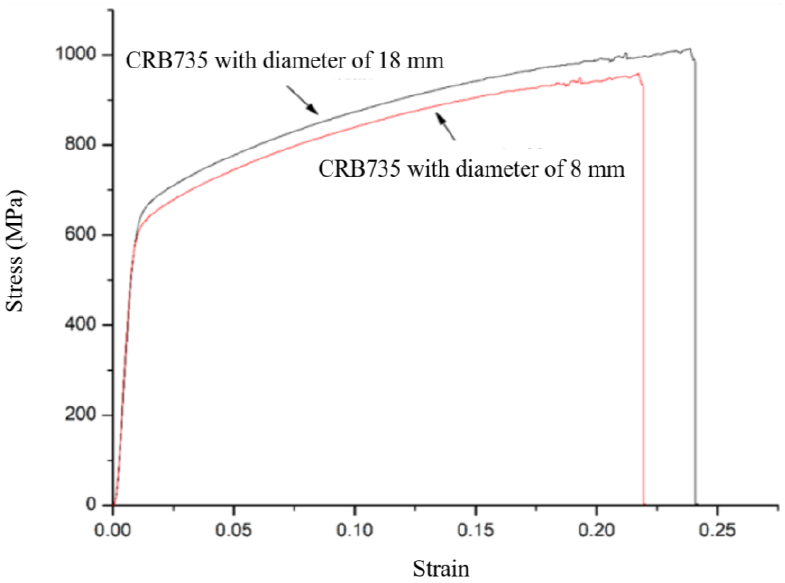
Figure 1. Stress-strain relationship curves for CRB735 with diameter of 8 mm and 18 mm.